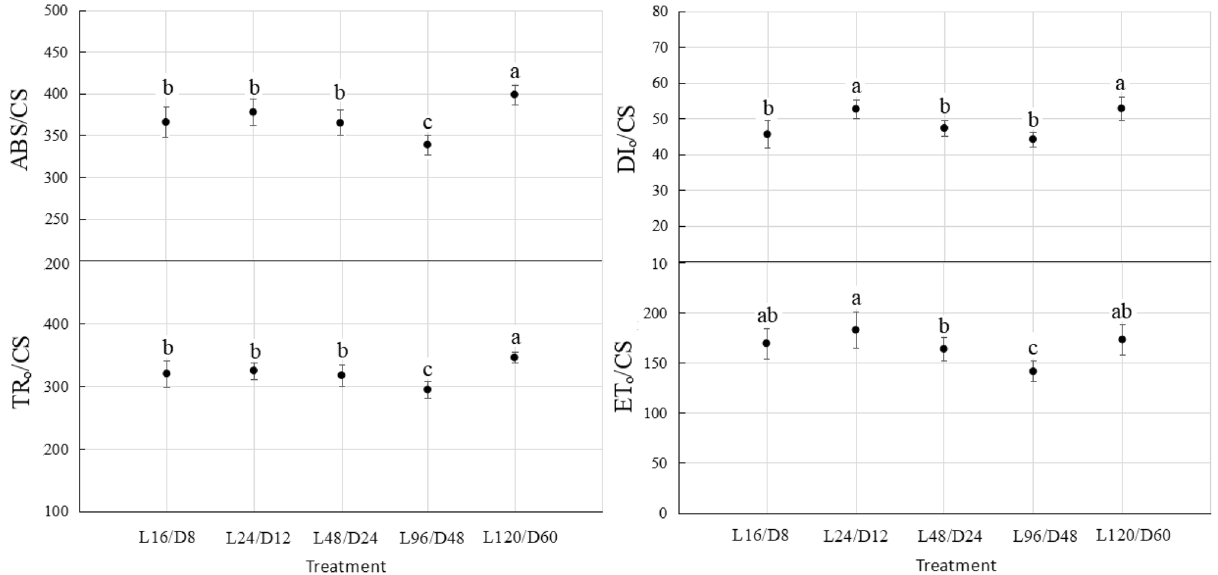
Figure 6. The energy flow allocations in the reaction center of PS II of lettuce exposed to different L/D cycle treatments of RB. Different letters for the same parameter indicate significant differences at the 5% level, according to the Tukey’s test (n = 3). The bars represent the standard errors. ABS/CS—optical energy absorbed; TR o /CS—optical energy trapped; ET o /CS—optical energy used for electron transfer; DI o /CS— thermal dissipation in per unit area. L/D—light/dark. L16/D8—16 h light/8 h dark (as control), L24/D12—24 h light/12 h dark, L48/D24—48 h light/24 h dark, L96/D48—96 h light/48 h dark, L120/D60—120 h light/60 h